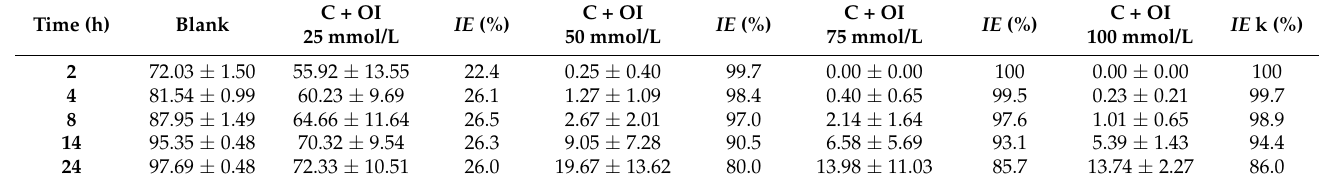
Table 7. Corrosion reduction efficiency according to Equation (6) for the spray corrosion measures at the given times for different concentrations of C + OI.